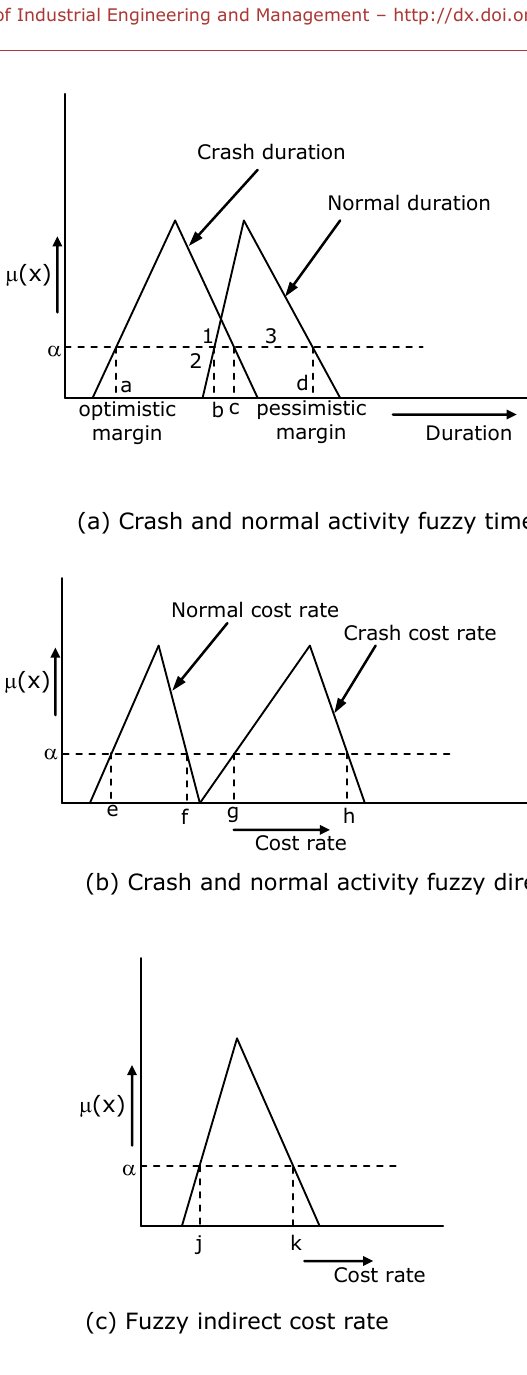
Figure 3. Fuzzy relationships between time and cost of an